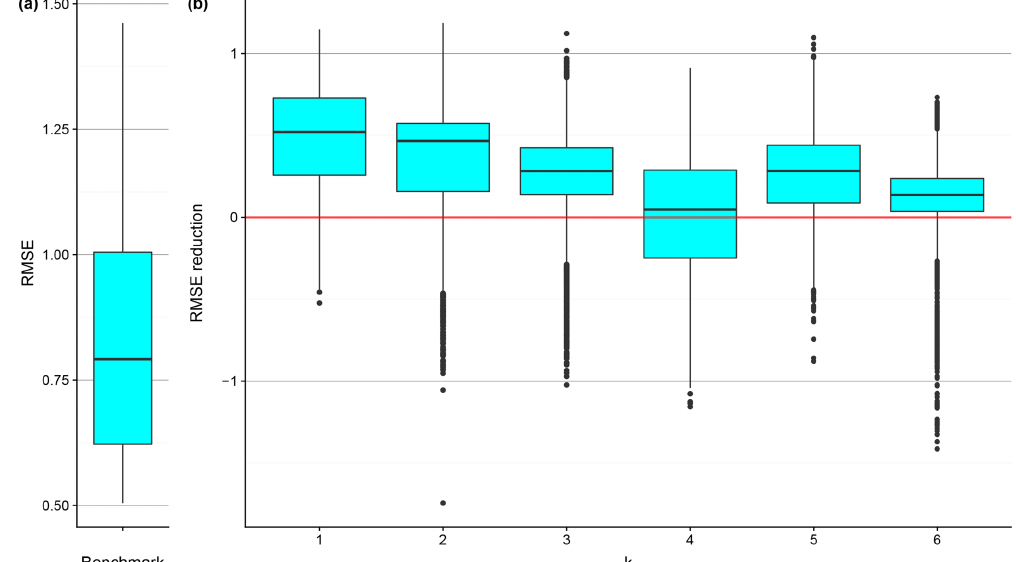
Figure 6. The box plot of the RMSE of the benchmark model at the testing watersheds (a) and the box plots of the RMSE reduction introduced by applying the BART models at the testing watersheds (b) . The red line indicates zero RMSE reduction for comparison.